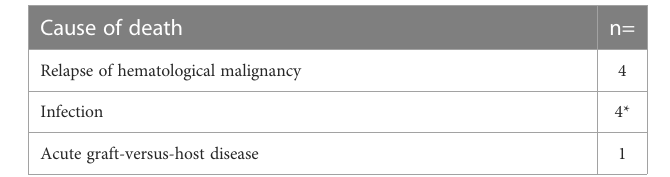
TABLE 2 Primary cause of death within 1 year after MSC